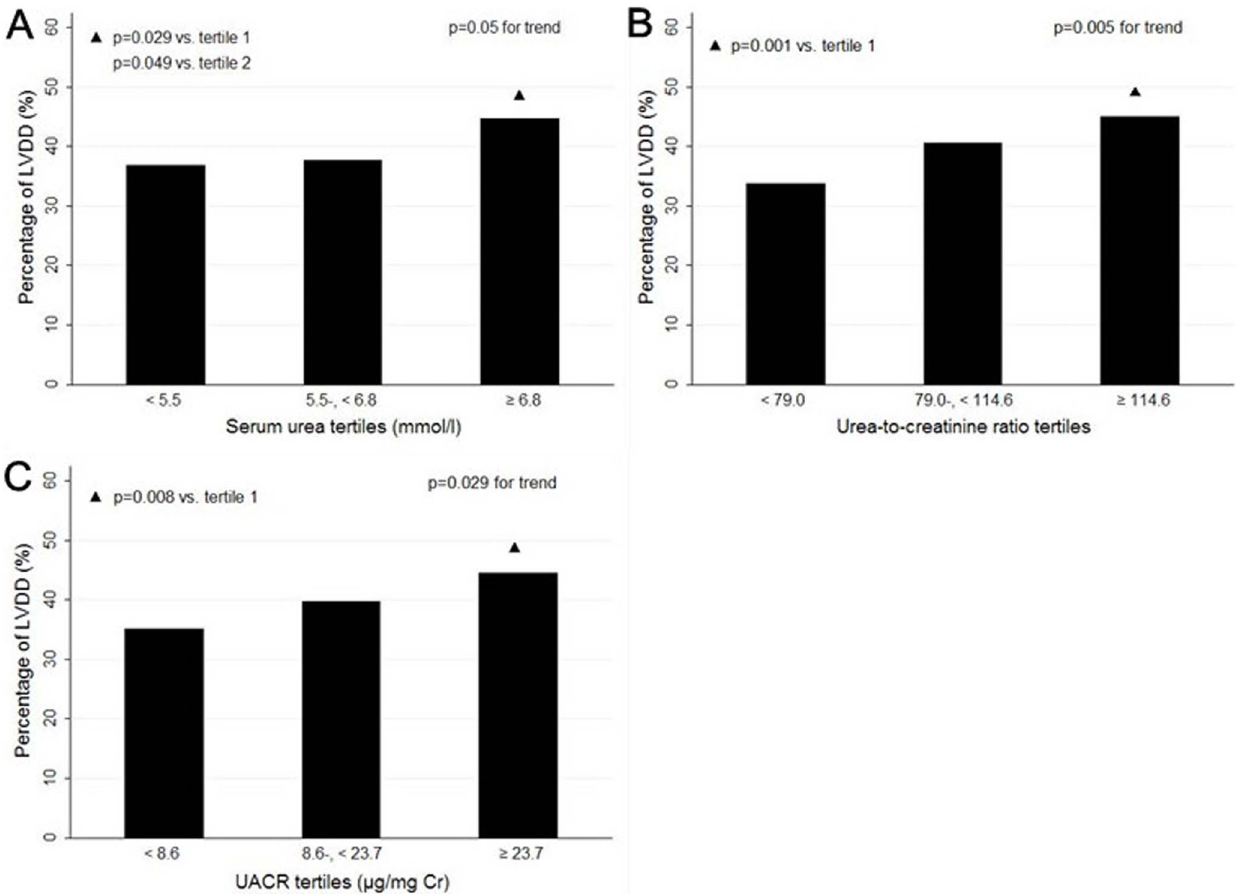
Figure 1. Prevalence of LVDD according to serum urea, urea-to-creatinine ratio, and UACR. The prevalence of LVDD is 36.9%, 37.6% and 44.6% in tertile 1, 2 and 3 of serum urea respectively. It is 33.8%, 40.5% and 45.1% for urea-to-creatinine ratio and 35.1%, 39.7% and 44.5% for UACR, respectively. LVDD, left ventricular diastolic dysfunction; UACR, urinary albumin-to-creatinine ratio.